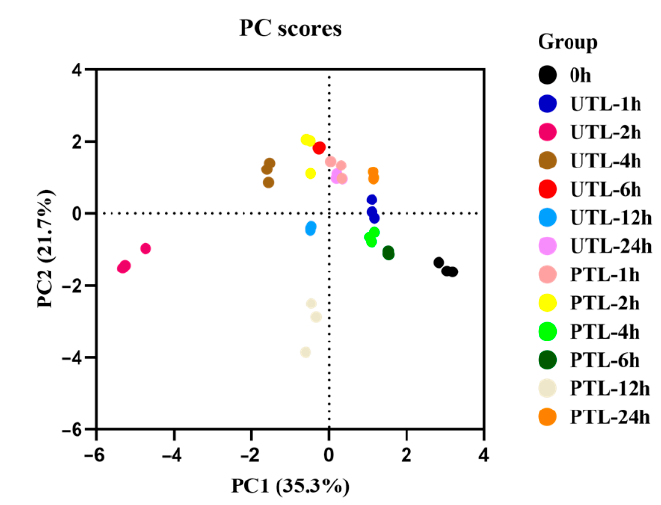
Figure 5. Graph of PC scores based on PCA.